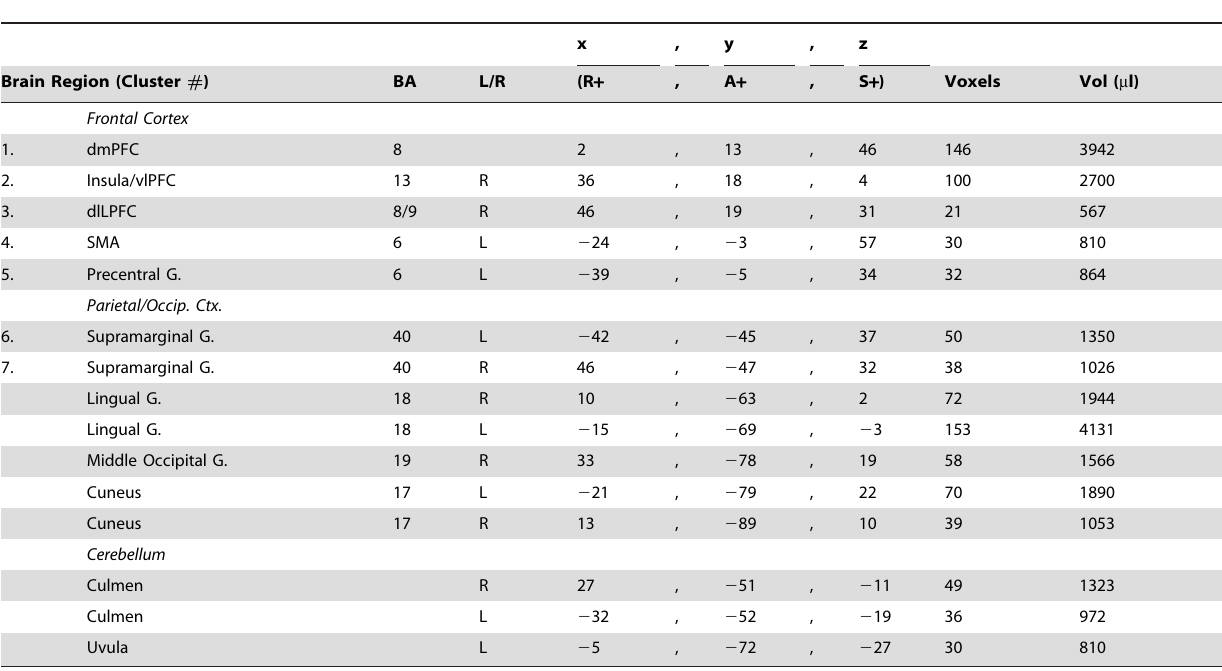
Brain region numbers correspond to those illustrated in Figureoˆ 4. Abbreviations: BA, Brodmann Area; L, left; R, right; A, anterior; S, superior; Vol ( m l), volume in microliters; dmPFC, dorsomedial prefrontal cortex; vlPFC, ventrolateral prefrontal cortex; dlPFC, dorsolateral prefrontal cortex; SMA, Supplementary Motor Area; G., gyrus; mid., middle.